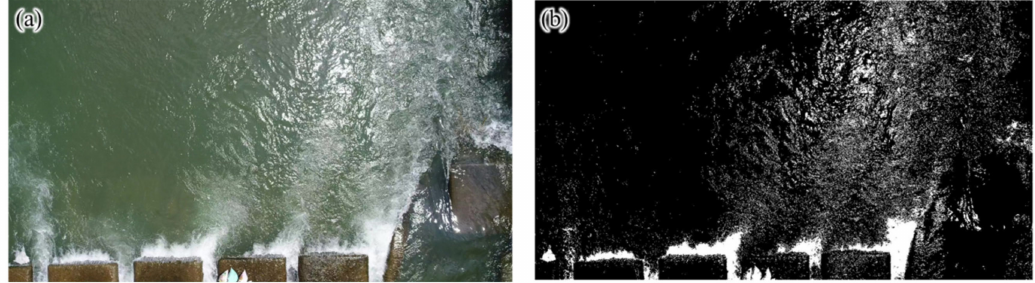
Figure 3. UAV shooting image on 31 May 2019; ( a ) original image and ( b ) image after